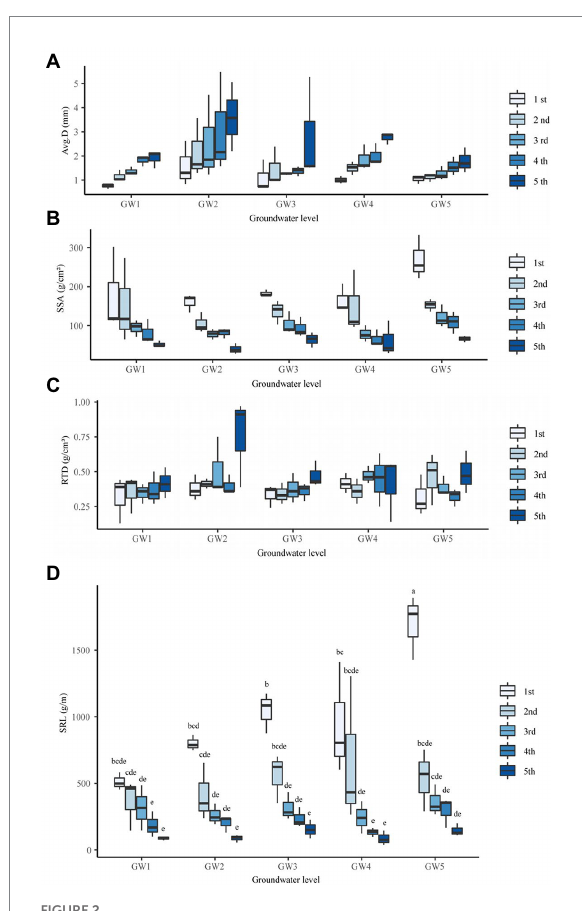
FIGURE 2 The Avg.D (A) , SSA (B) , RTD (C) , and SRL (D) of different orders of fine roots of Tamarix chinensis at different groundwater levels. SSA, Specific surface area; RTD, Root Tissue Density; SRL, Specific Root